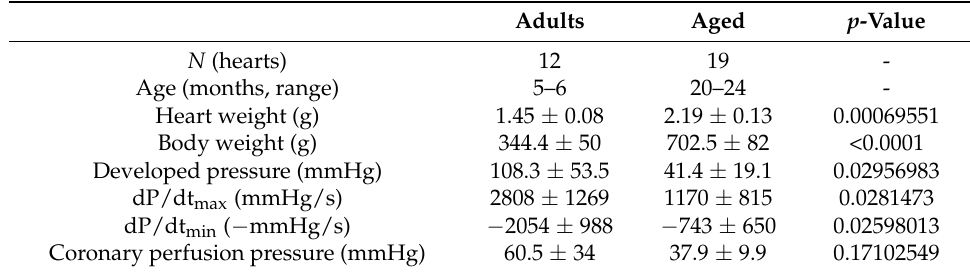
Table 1. Baseline characteristics of isolated hearts. Mean ± standard deviation.